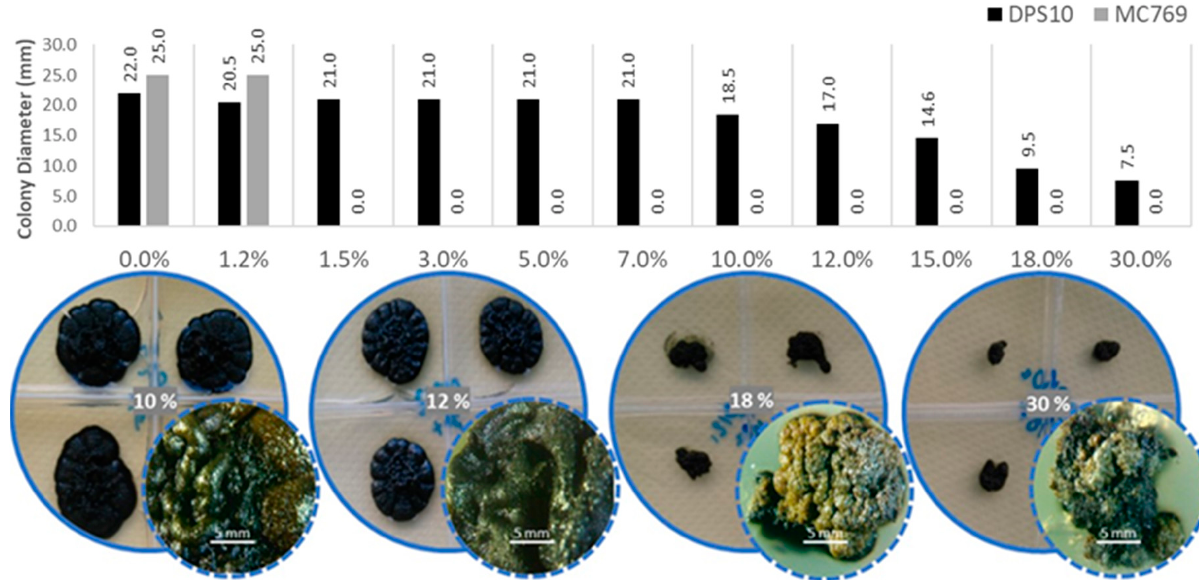
Figure 4. Salinity preferences of Pseudotaeniolina globosa DPS10 isolate shown by the colony diameter reached on MEA medium after one-month incubation at 25 ◦ C. Column chart in the upper part exhibit comparison of DPS10 and MC769 isolates in medium supplemented with 0.0, 1.2, 1.5, 3.0, 5.0, 7.0, 10.0, 12.0, 15.0, 18.0 and 30.0% NaCl. Visual examination of the cultured plates in the lower part shows the growth of DPS10 isolate at 10.0, 12.0, 18.0, and 30.0% NaCl in quadruplicates (Petri dish of four divisions) with a stereomicroscopic focus for one of the grown colonies (bar = 5 mm). Data on MC769 isolate come from De Leo et al. [16].